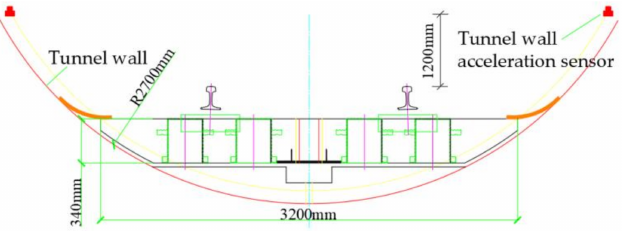
Figure 7. Layout of measuring points for the tunnel-wall acceleration sensor.